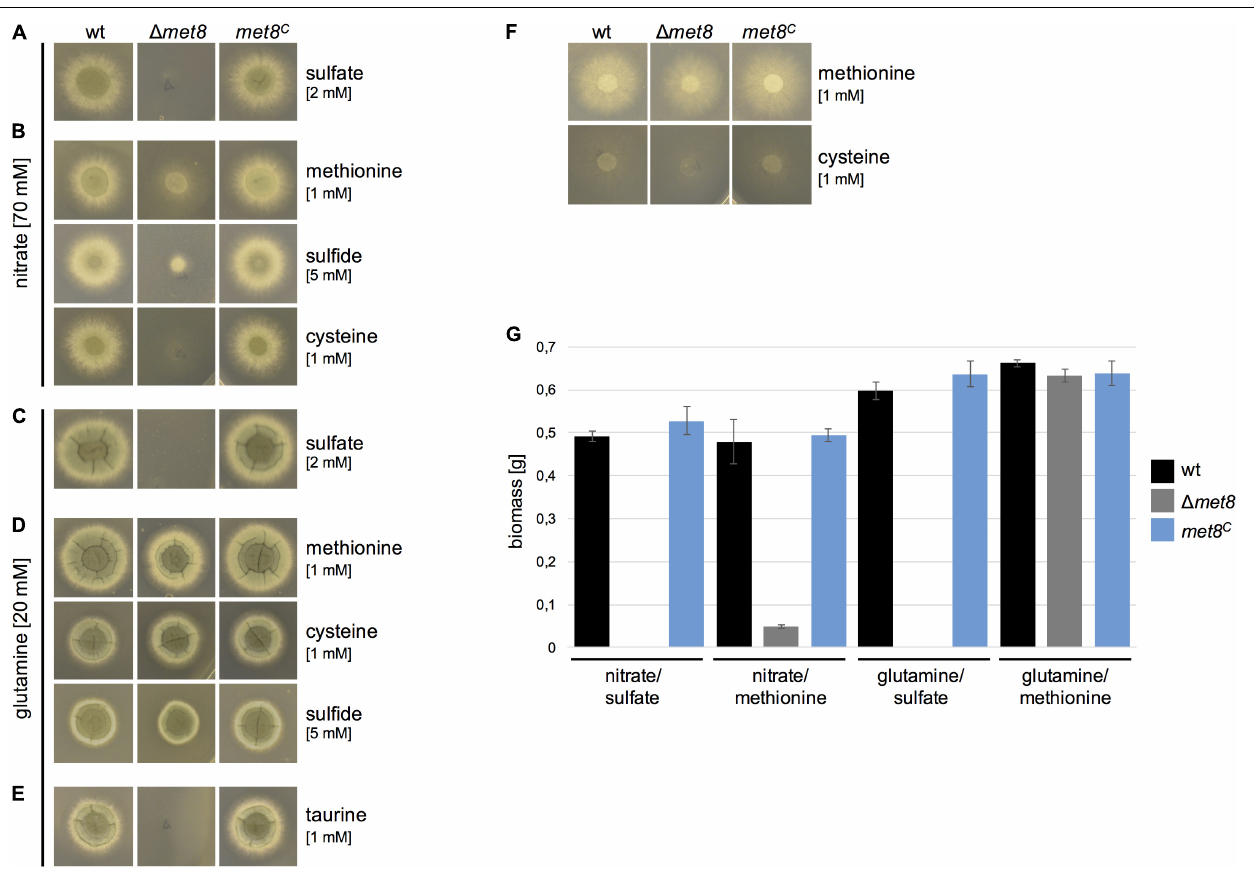
FIGURE 3 | Deletion of met8 in A. fumigatus impairs assimilation of nitrate and sulfate. (A–E) 10 4 spores of the respective fungal strains were point-inoculated on minimal medium supplemented with either nitrate or glutamine as N -source and sulfate, taurine, sulfide, cysteine or methionine as S -source, respectively. In (F) , methionine or cysteine served as both sulfur and nitrogen source. Photographs were taken after 48 h of incubation at 37 ◦ C. (G) Biomass production (dry weight) of wt, (cid:49) met8 and met8 C was quantified after growth for 22 h in liquid minimal medium. Cultures were supplemented as indicated with either 70 mM nitrate, 20 mM glutamine and/or 5 mM methionine. Data represent the mean of three biological replicates ± standard deviation. Minimal medium contains 2.2 mM